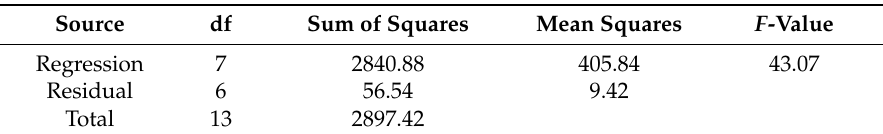
Table 9. ANOVA for the